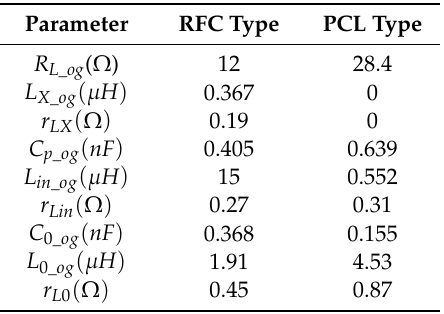
Table 1. Theoretical parameter values of class-E.